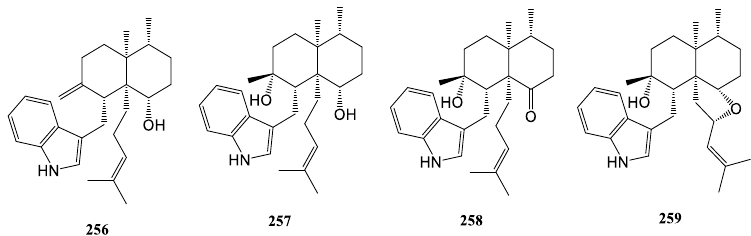
Figure 13. Structures of nominine/penicilindoles indole diterpenes.